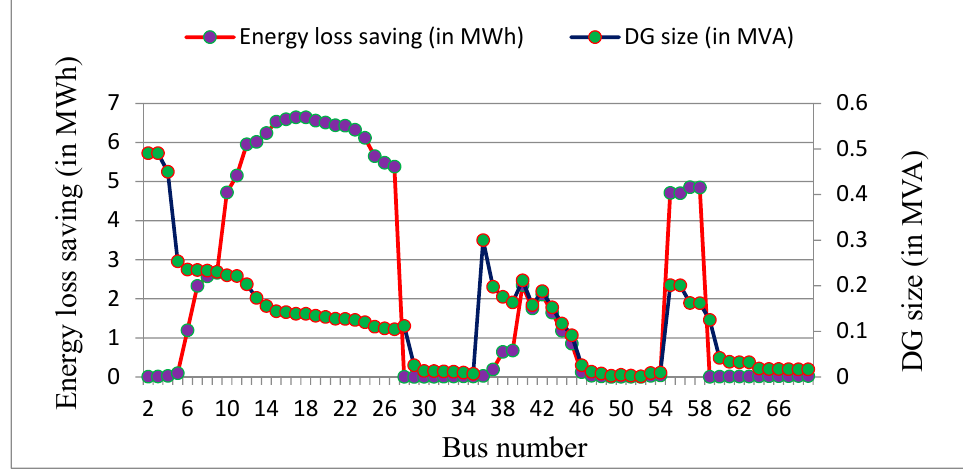
Figure 8. Loss savings of active energy component with subsequent size of DGs (in MVA) for dif- ferent nodes for first iteration with DG placed at node 50 for IEEE 69-bus system.